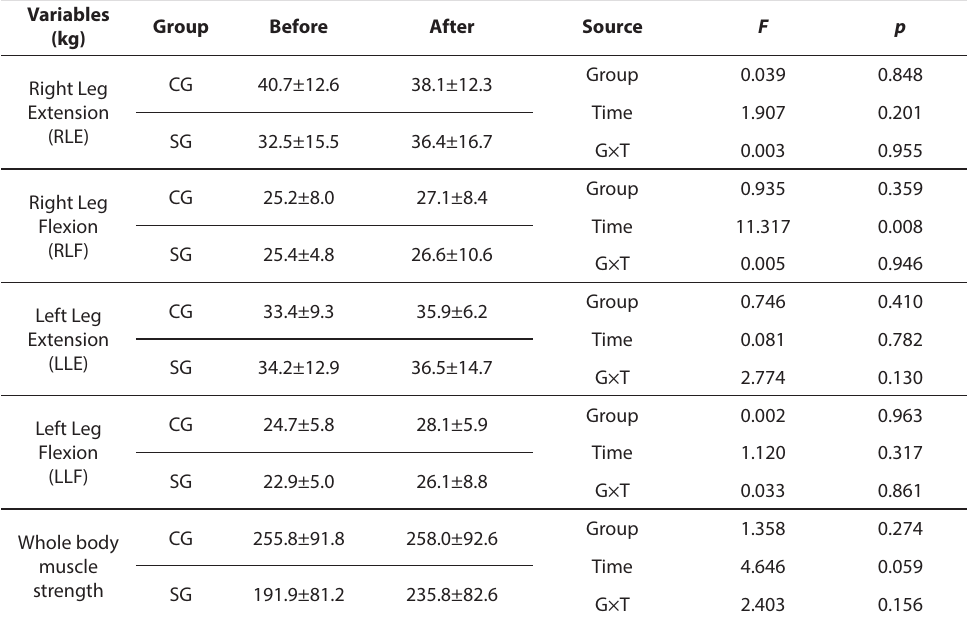
TABLE 4. Effects of a Four-week Core Stability Exercise on